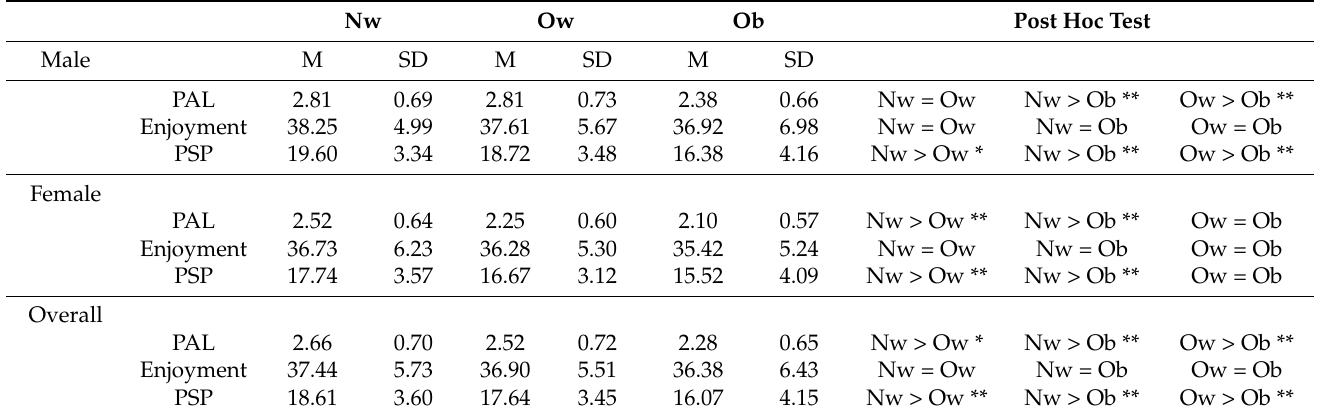
Table 2. Measures of Physical Activity Level (PAL), Enjoyment, and Physical Self-Perception (PSP). Nw Ow Ob